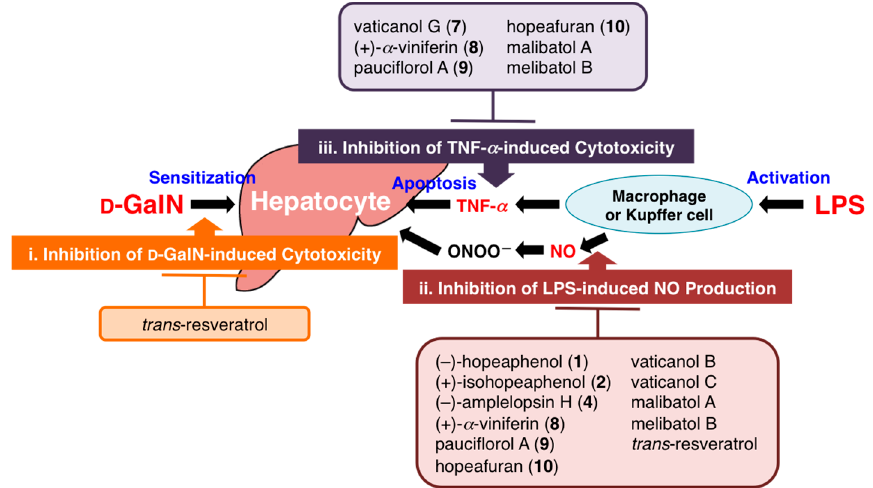
Figure 3. Plausible mechanisms of action of stilbenoids on D -GalN/LPS-induced liver injury.